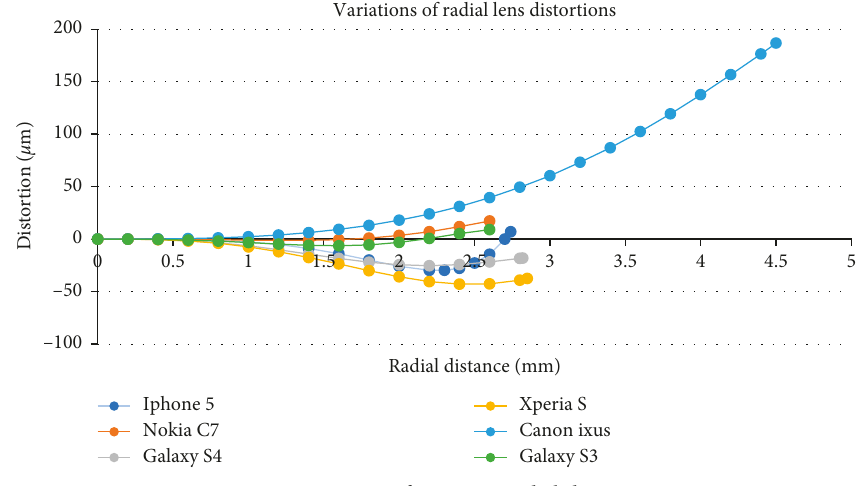
Figure 2: Variation of Gaussian radial